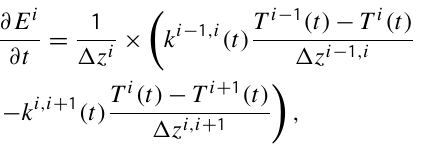
Table 4. Model parameters assumed in all CryoGrid 3 and CryoGrid 3 Xice simulations. Snow density ρ snow 200–250 kgm − 3 Boike et al. (2013) Albedo snow-free surface α summer 0.2 Langer et al. (2011a) Albedo pond/lake α lake 0.07 Burt (1954) Albedo fresh snow α max 0.85 ECMWF (2006) Albedo old snow α min 0.50 ECMWF (2006) Time constant of snow albedo change – non-melting τ α, f 0.008 Time constant of snow albedo change – melting τ α, m SW-radiation extinction coefficient in snow New snowfall threshold SWE SF Surface resistance snow-free surface r s Roughness length snow-free surface z 0 , summer Roughness length snow z 0 , winter Emissivity snow-free surface ε snow Emissivity snow ε snow Geothermal heat flux k